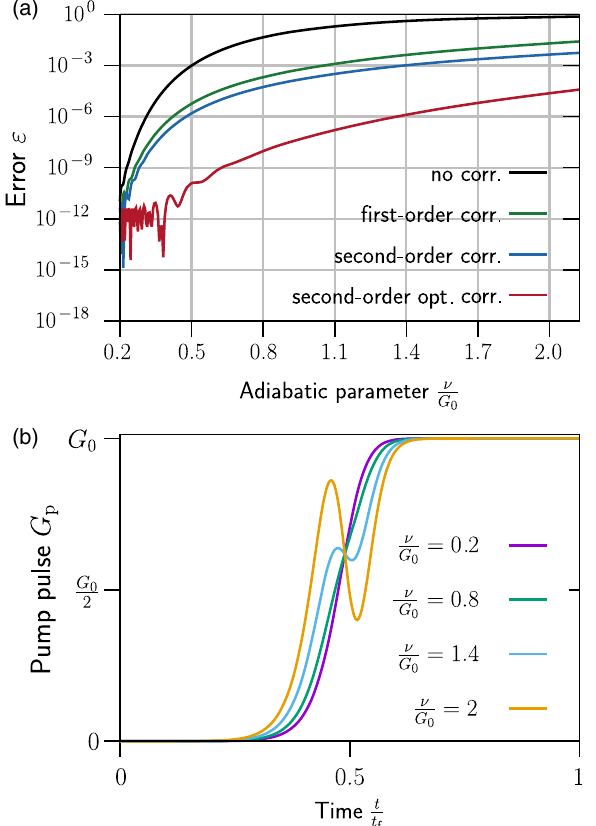
FIG. 3. (a) Fidelity error for STIRAP-style adiabatic state transfer in a Λ system [cf. Eq. (35)], as a function of the adiabatic parameter ν =G 0 . Different curves correspond to different choices of control corrections: “ Uncorrected ” control sequence defined in Eq. (36) (black), first-order Magnus corrected controls (green), second-order Magnus corrected controls (blue), and the optimal second-order Magnus corrected controls (red). (b) Modified t Þ predicted by the second-order Magnus pump pulse G p ð algorithm as a function of t=t for different values of ν =G 0 . f As ν =G 0 → 0 , the modified sequence converges to the original t Þ is the time reverse of the pump one. The Stokes pulse G s ð